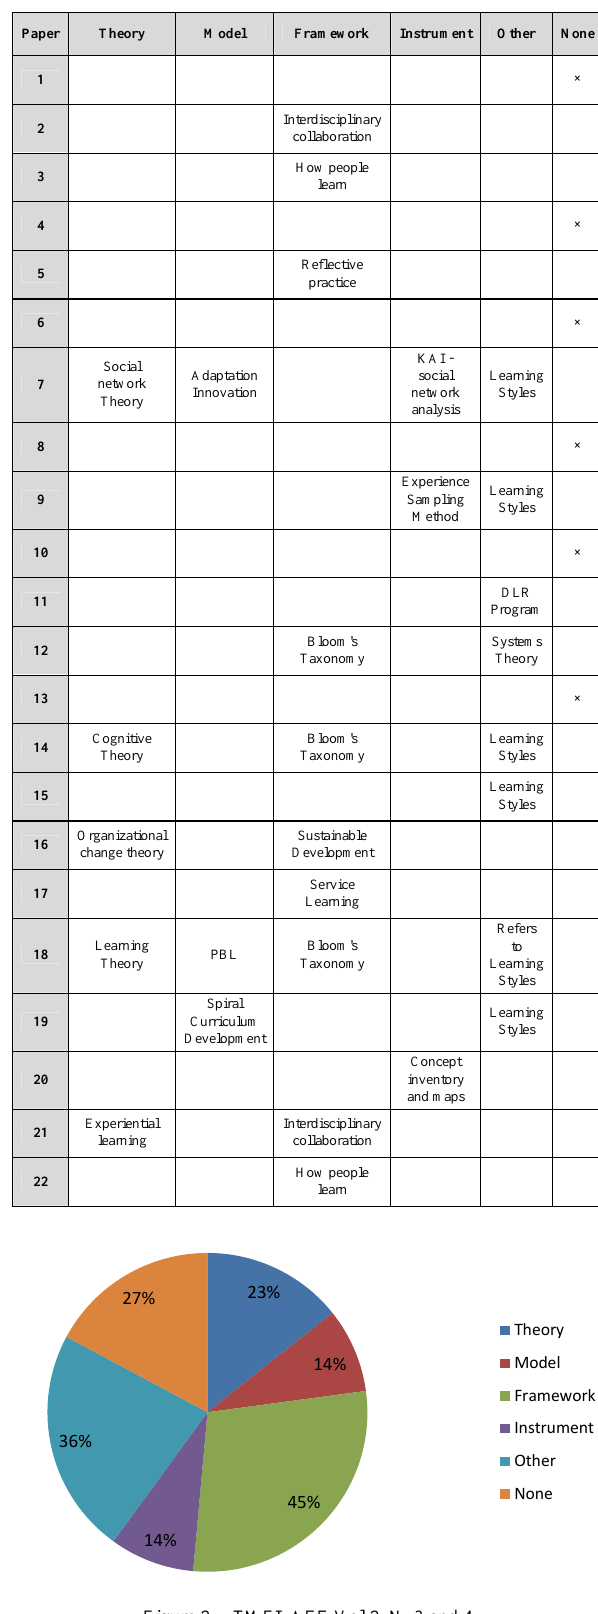
Figure 2. TMFI, AEE Vol.2, N. 3 and